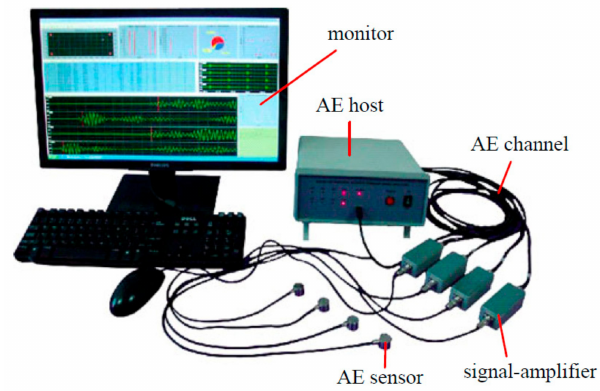
Figure 6. AE signal analyzer